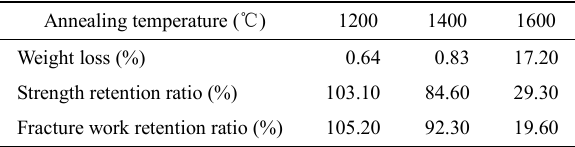
Weight loss and mechanical properties of C/mullite composites after annealing